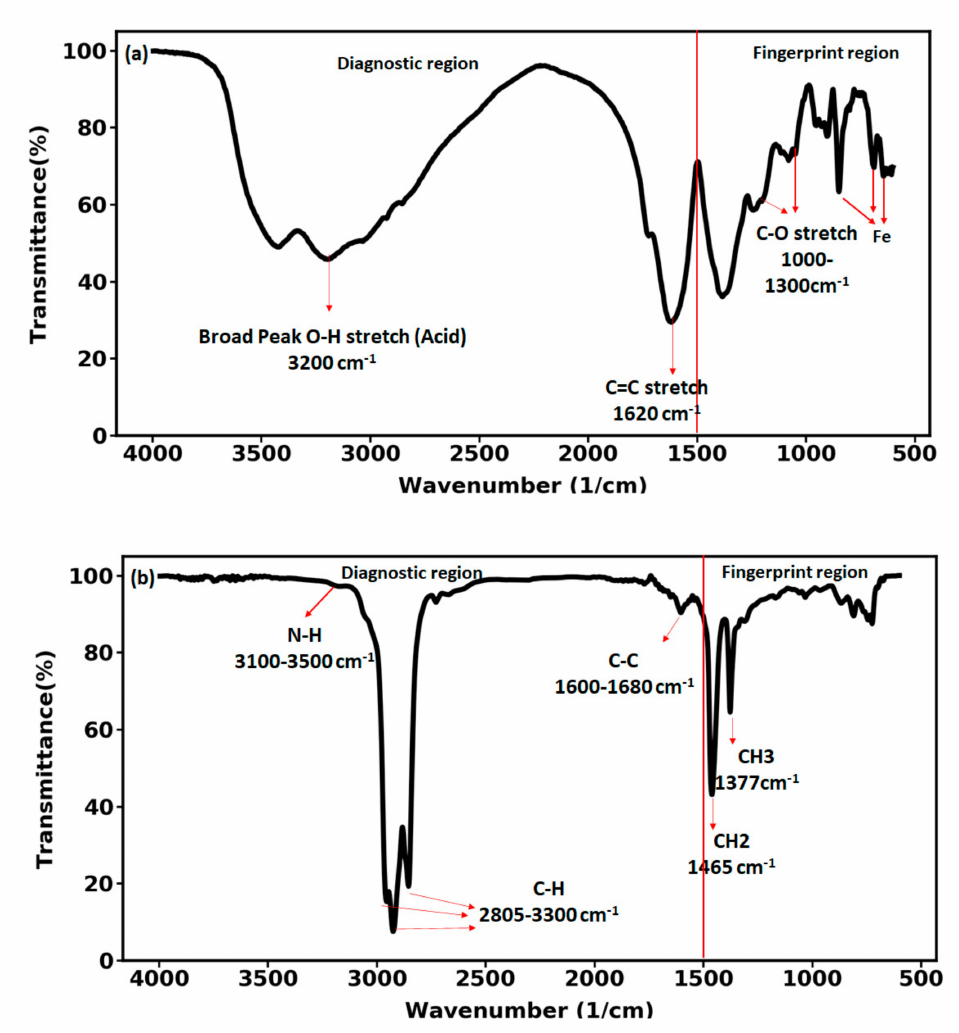
Figure 8. FTIR spectrum of ( a ) the iron-carbon nanohybrid ( b ) the crude